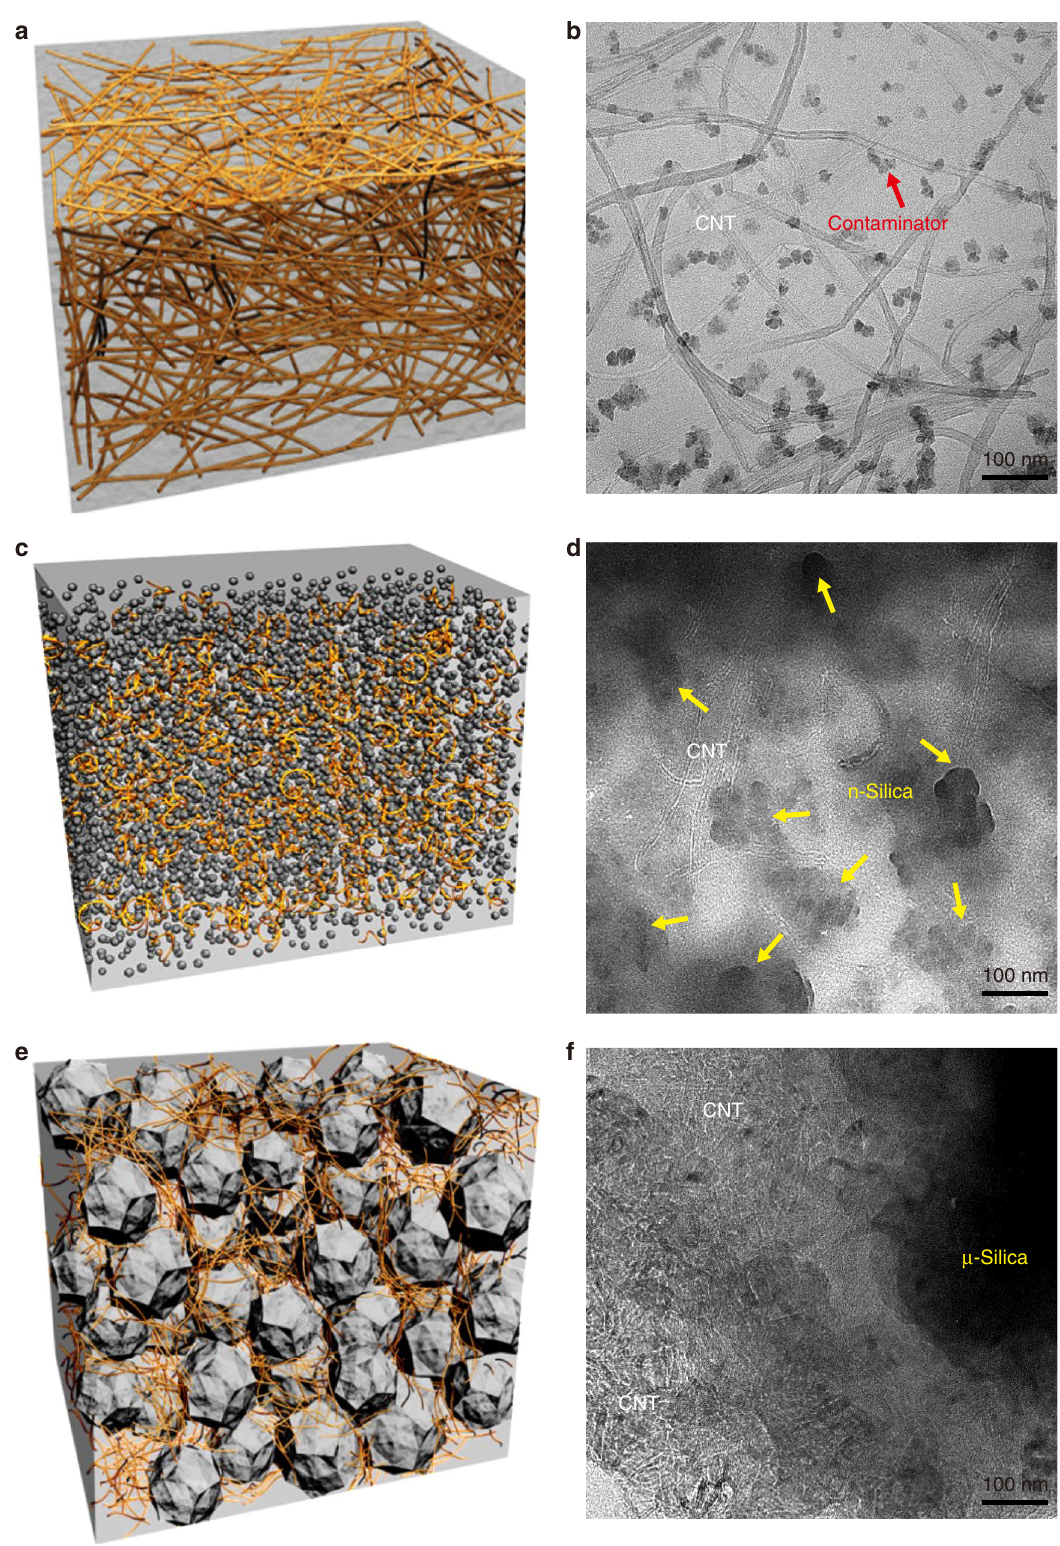
Fig. 3 Graphical schemes and TEM images. a , b CNT composite without silica. c , d Nano-silica fi llers with diameter of 20 nm. e , f Micro-silica fi llers with diameter of 3 – 4 μ